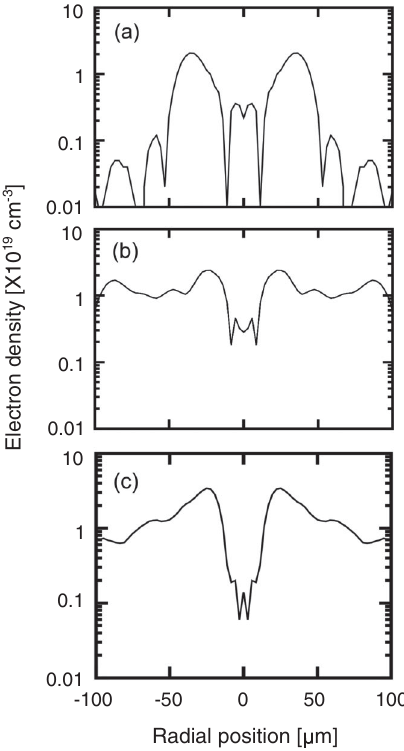
FIG. 10. Transverse electron density distribution at different positions: A, B, and C as in Fig.